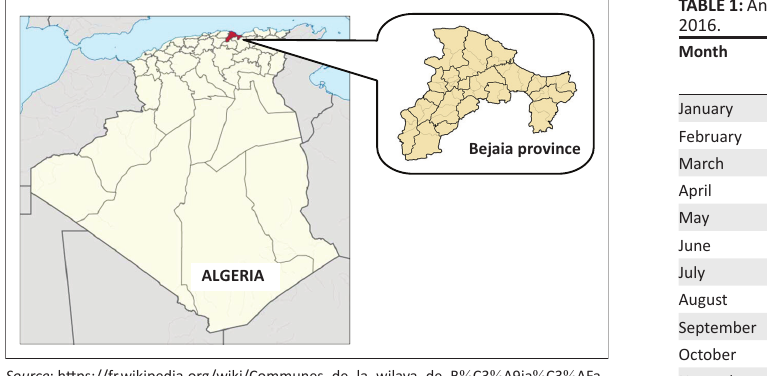
FIGURE 1: Map of the study area, Bejaia rainfall in the region averages 680 mm. The mean maximum summer temperature reaches 25.3 °C (August) and the mean minimum winter temperature falls to 13.4 °C (March). The monthly rainfall and mean temperature during the period of the present study are presented in Table 1.